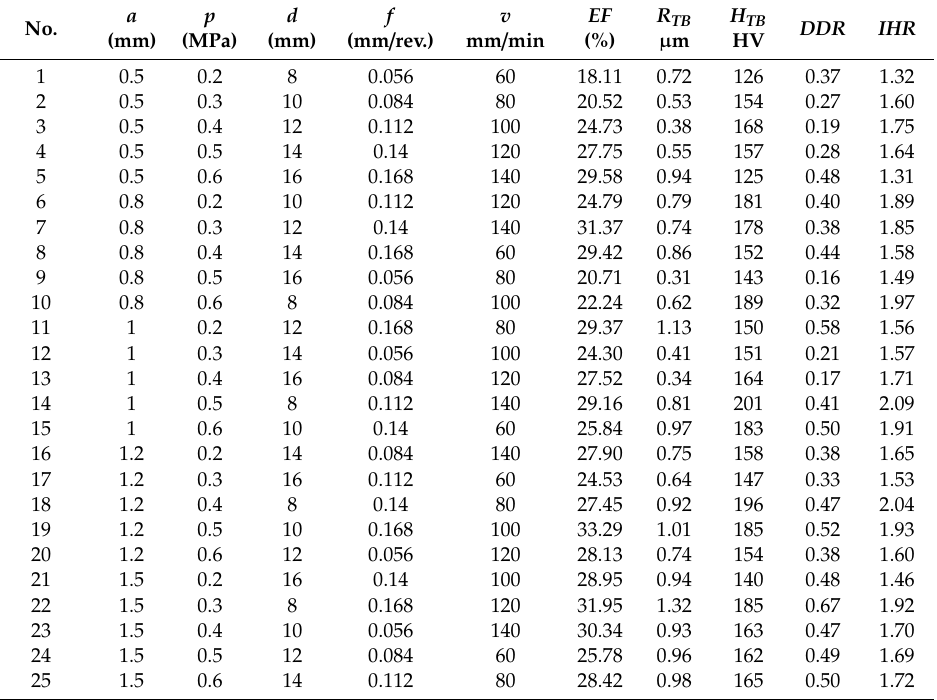
Table A1. Experimental data of the hybrid